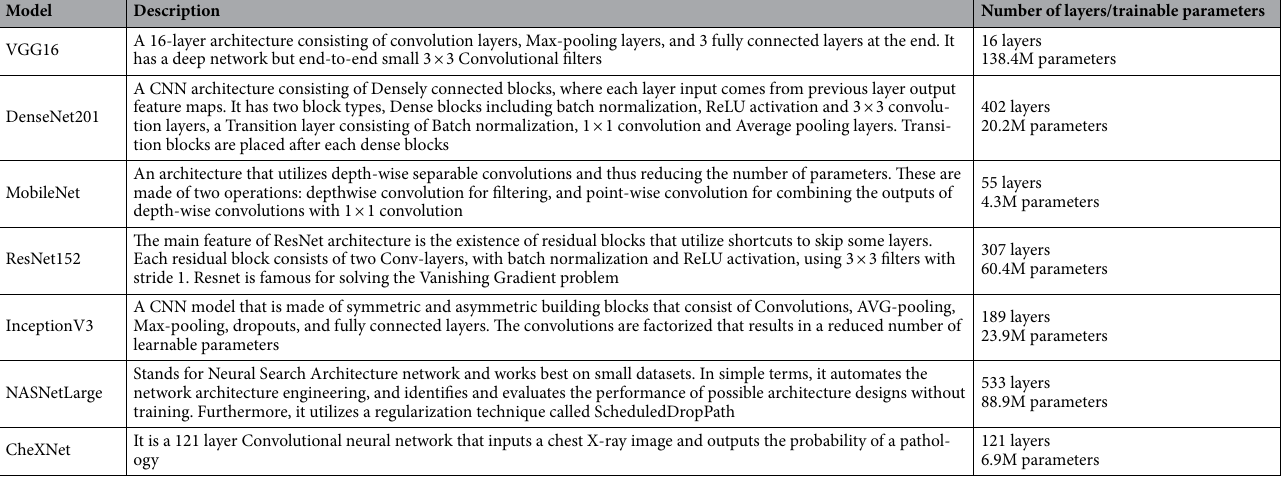
Table 4. Different DCNN models trained in this study and model